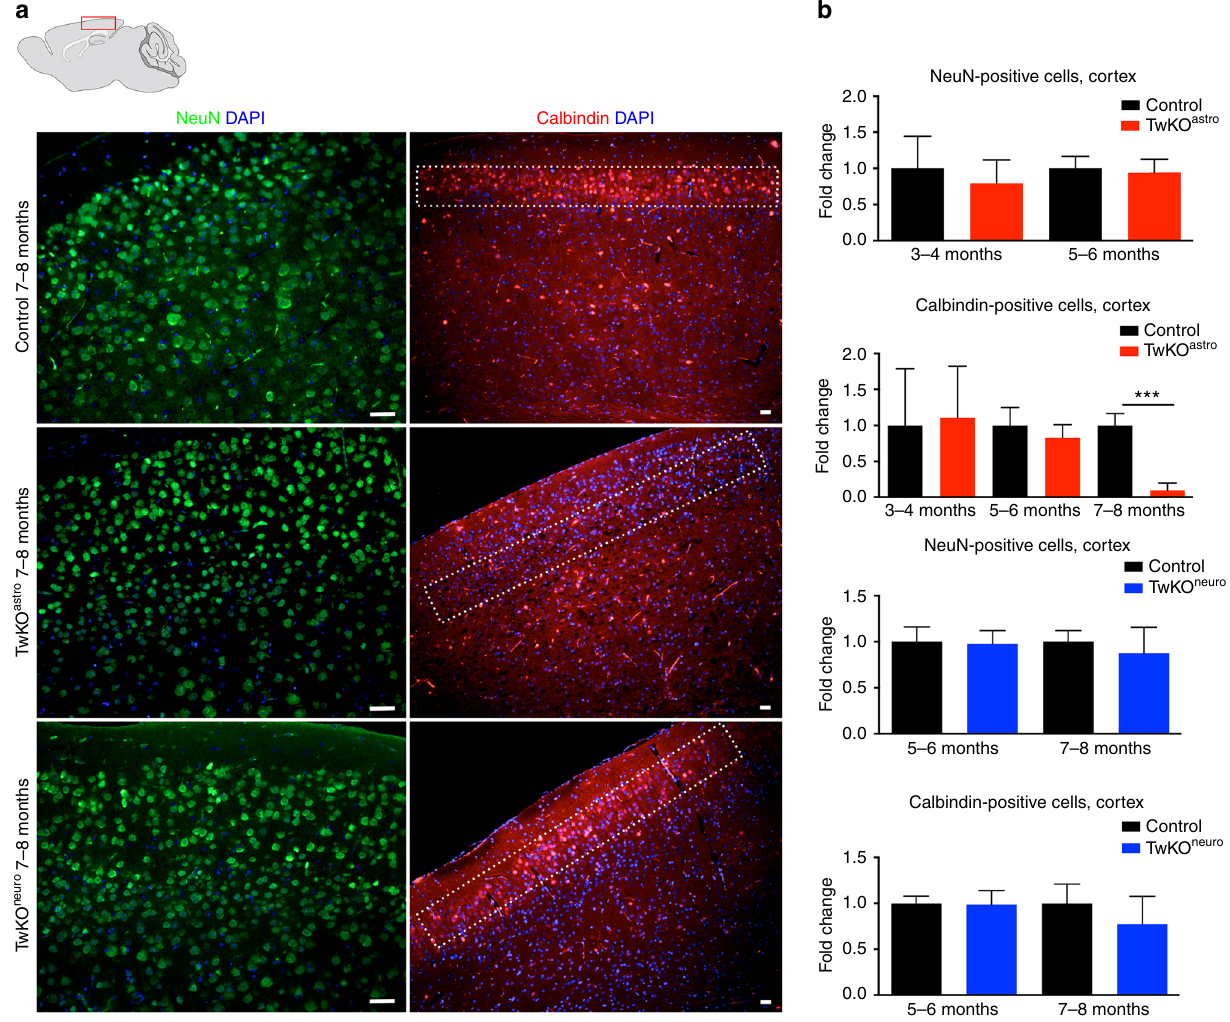
Fig. 6 MtDNA loss in astrocytes depletes Calbindin-positive interneurons in cortex, upper neuronal layers. Immuno fl uorescnece staining of mid-sagittal sections of 7 – 8 months old mice, brain graph shows sampling site. a Neuronal nuclei (NeuN, green), Calbindin-positive neurons (red) and nucleus (DAPI, blue). b Quanti fi cation of NeuN-and Calbindin-positive neurons in somatosensory cortex, cortical layers I and II are boxed. Scale bars: 20 μ m. The data are presented as mean and error bars indicate standard deviation. Statistical signi fi cance: *** p <